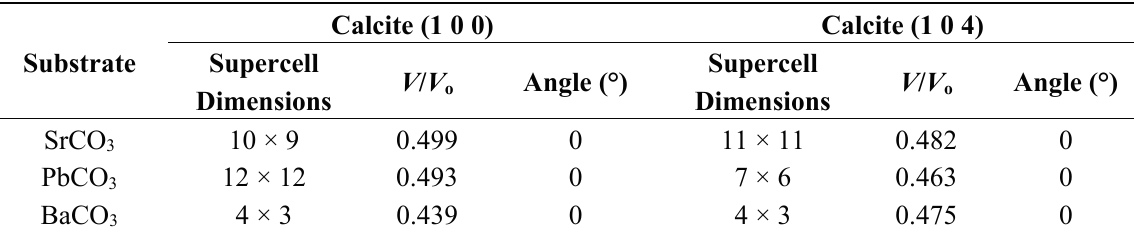
Table 3. The maximum size of supercell dimensions along with the azimuthal angles that generated the dimensionless potential ( V / V o ) less than 0.5, when the epitaxy relationships between the (0 0 1) planes of the substrates and the (1 0 0) or (1 0 4) planes of calcite were calculated.